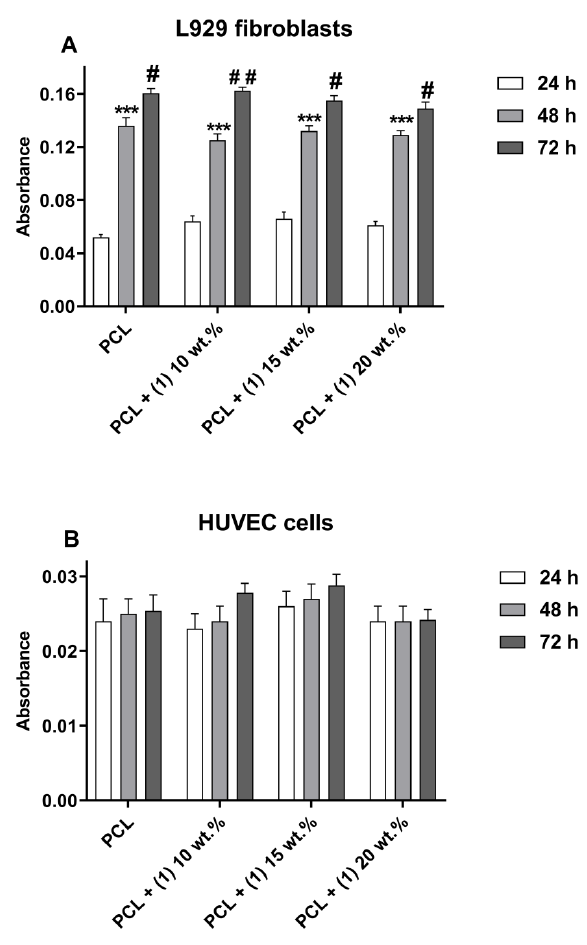
Figure 3. The viability of L929 fibroblasts ( A ) and HUVEC cells ( B ) directly cultured on the surfaces of PCL and PCL + ( 1 ) for 24, 48 and 72 h. The absorbance values are expressed as means ± SEM of five independent experiments. Asterisks indicate significant differences in the cell viability between 24 and 48 h (*** p < 0.001), whereas hash marks between 48 and 72 h (# p < 0.005; ## p < 0.010). Comparative SEM images of L929 fibroblasts and HUVEC cells cultured on the